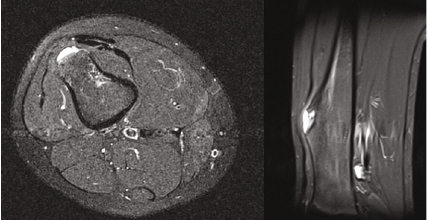
Figure 8: Magnetic resonance images (MRI) (machine settings: thickness 5.0 mm, fat-suppressed axial, and short-T1 inversion recovery (STIR) sagittal) demonstrating a distal femoral lesion consistent with likely osteochondroma.